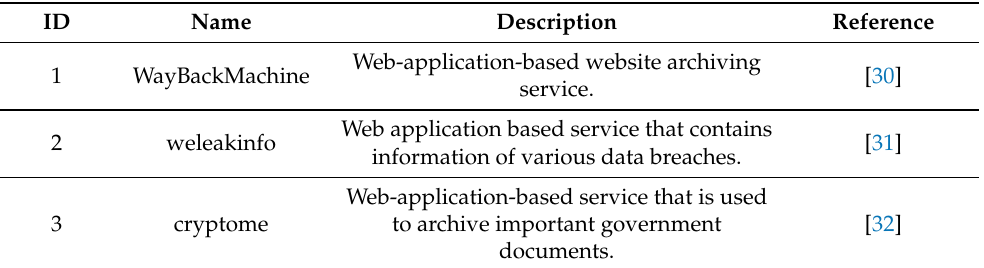
Table 3. Tools used to obtain the OSINT information from archived data on publicly available sources.